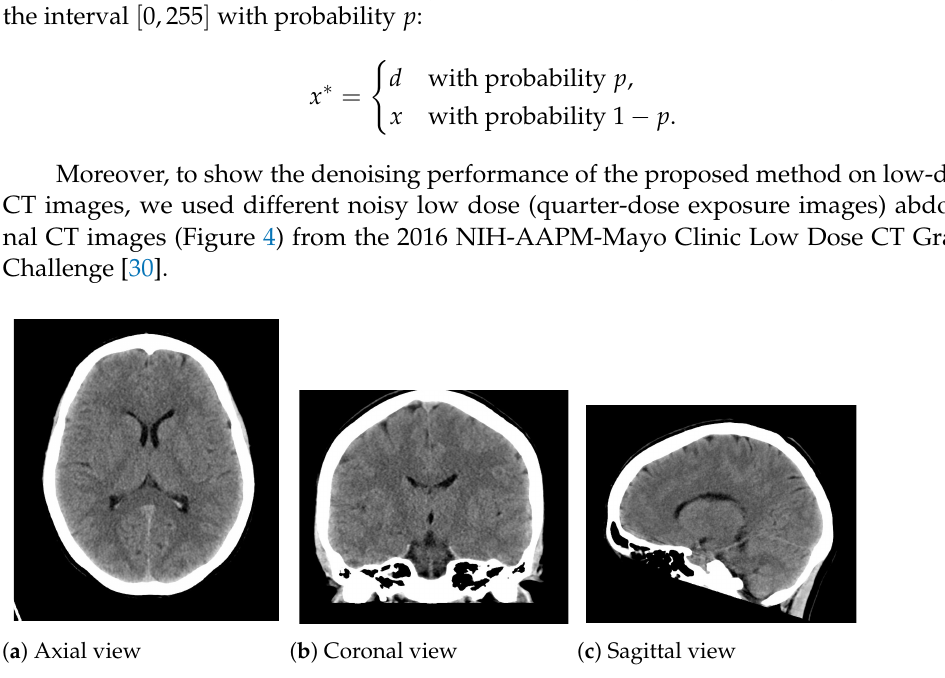
Figure 3. CT medical images utilized in the experimentation. ( a ) Axial view: 1024 × 904